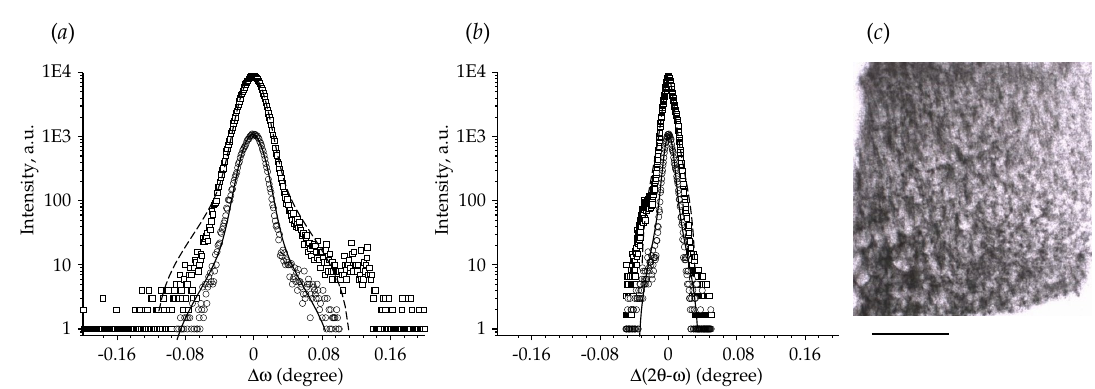
Figure 4. Superimposed symmetric and asymmetric ω and 2 θ − ω X-ray diffraction peaks for type I layer of AlN. ( a ) X-ray rocking curves ( ω –scans) from 0004 (squares) and 1014 (circles) reflections. Log scale. The peaks have fitted widths of 96 and 92 arcsec, respectively. Voight fit is shown by dashed and solid lines; ( b ) (2 θ − ω ) scans from 0004 and 1014 reflections. The peaks have fitted widths of 38 and 39 arcs, respectively; ( c ) X-ray topograph of a type I layer taken using white radiation in transmission setting. Film Kodak SR45. Scale bar 0.8 mm.